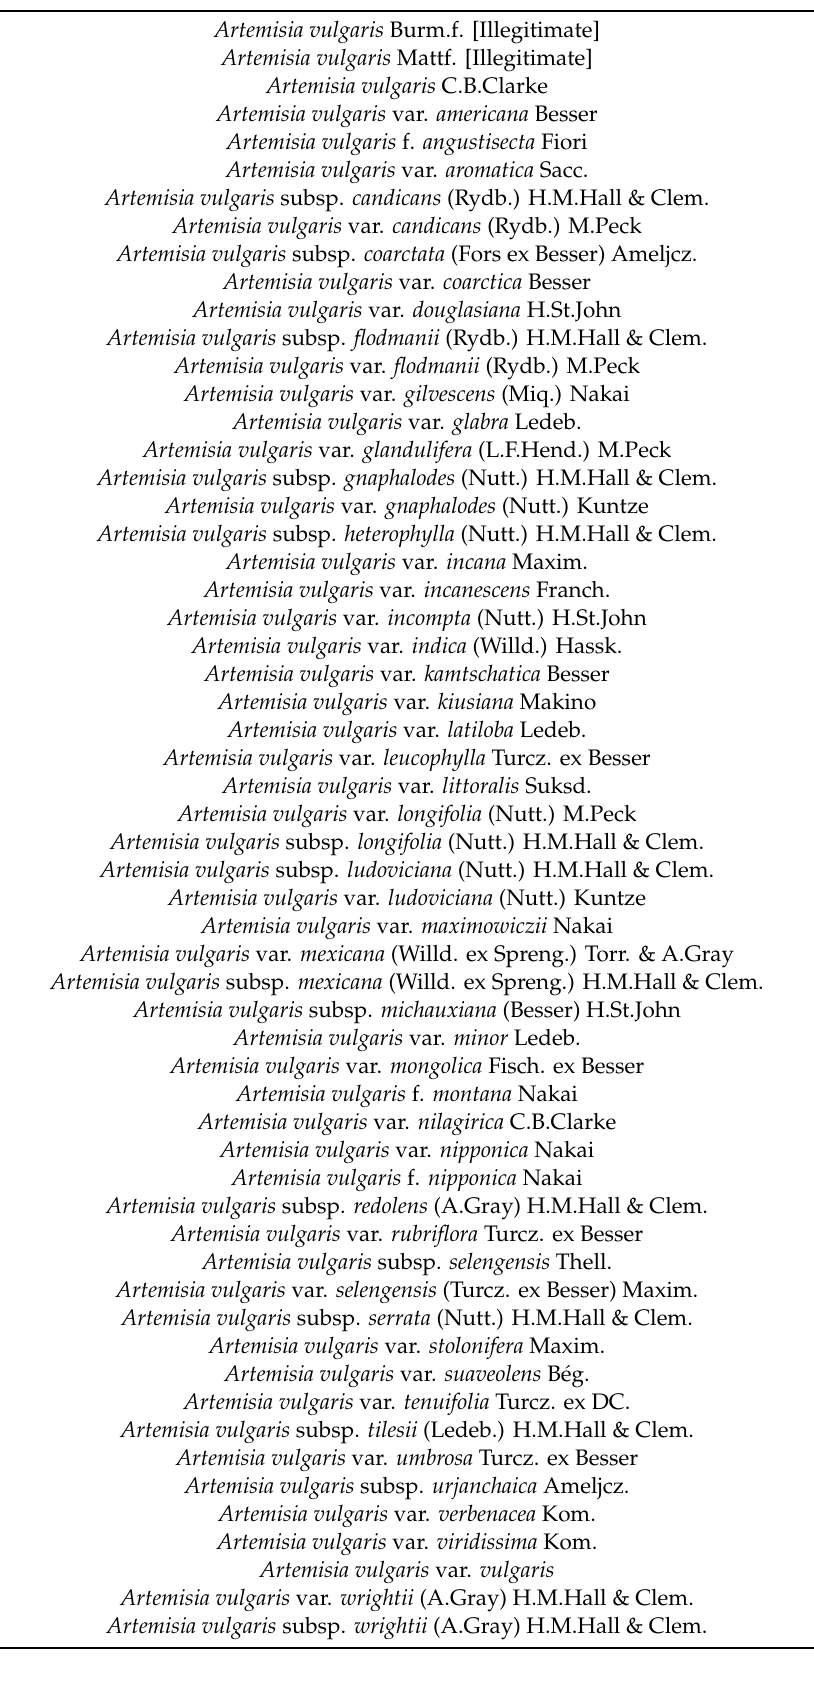
Table 1. The Latin synonymous names of A. vulgaris